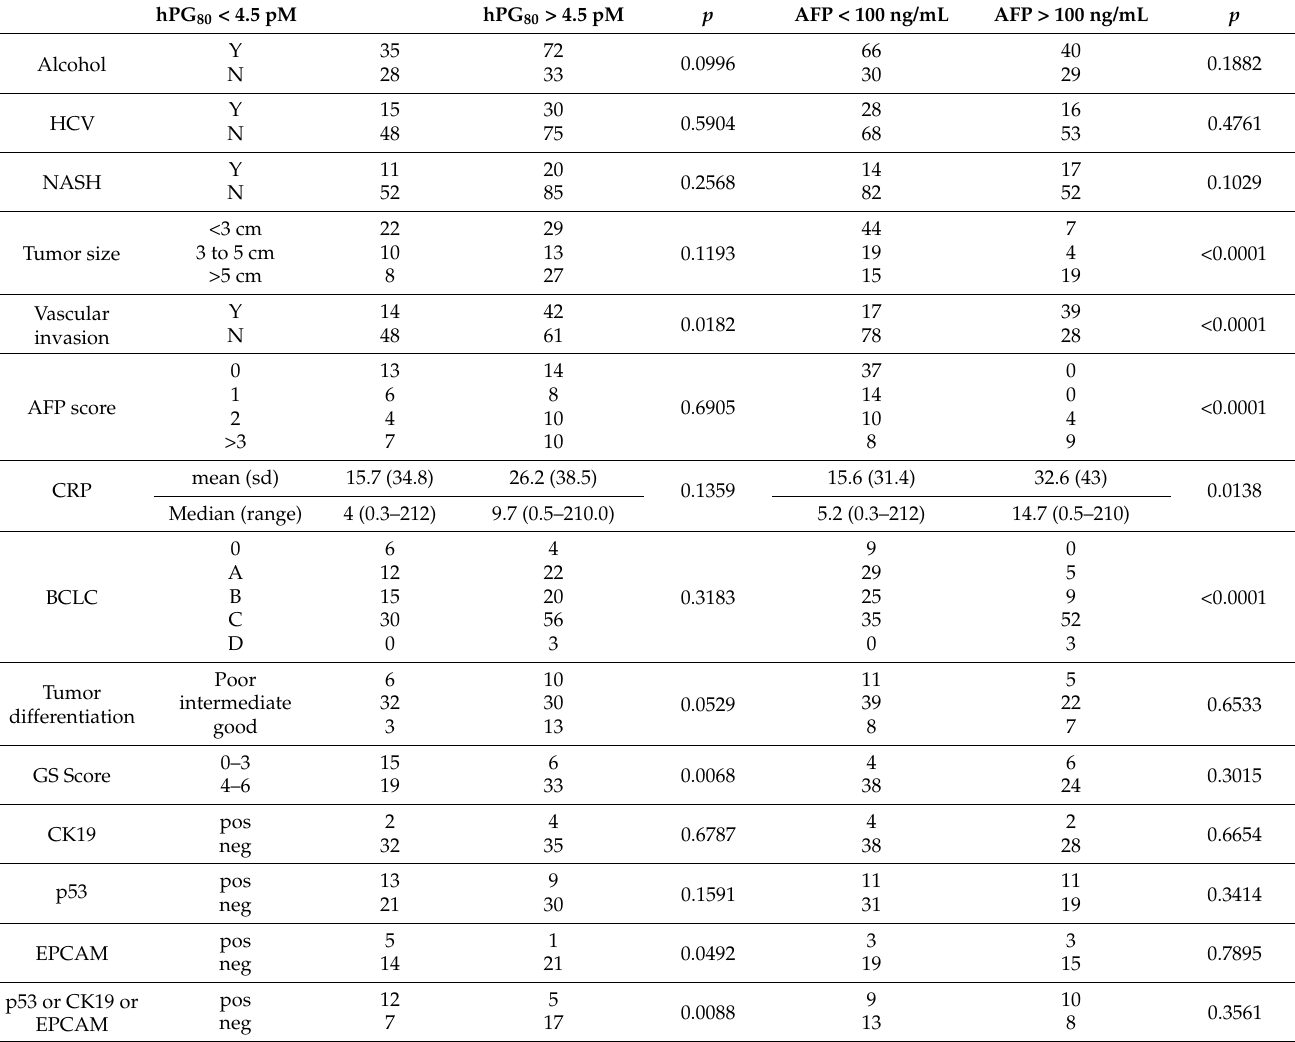
Table 2. hPG 80 and AFP levels co-variables